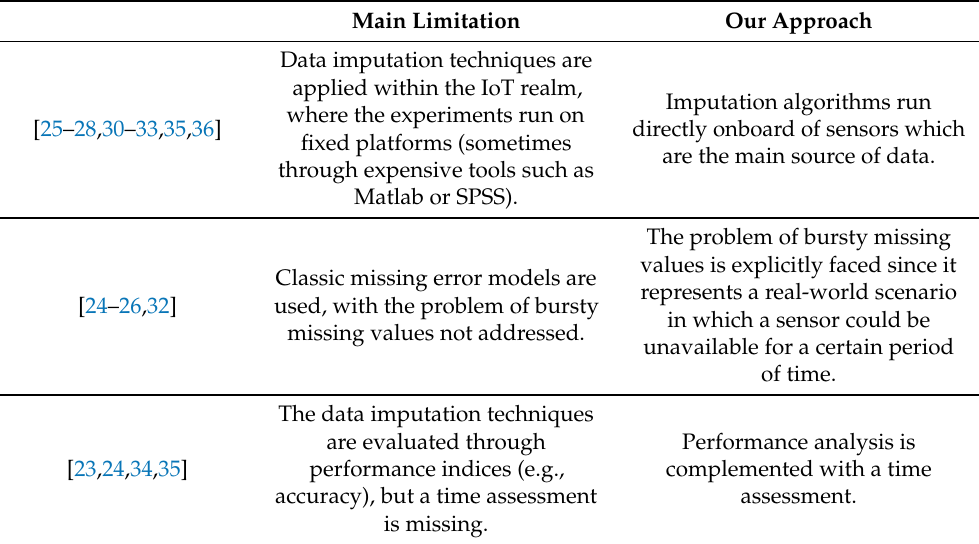
Table 1. Summary of differences/limitations of surveyed work with respect to our